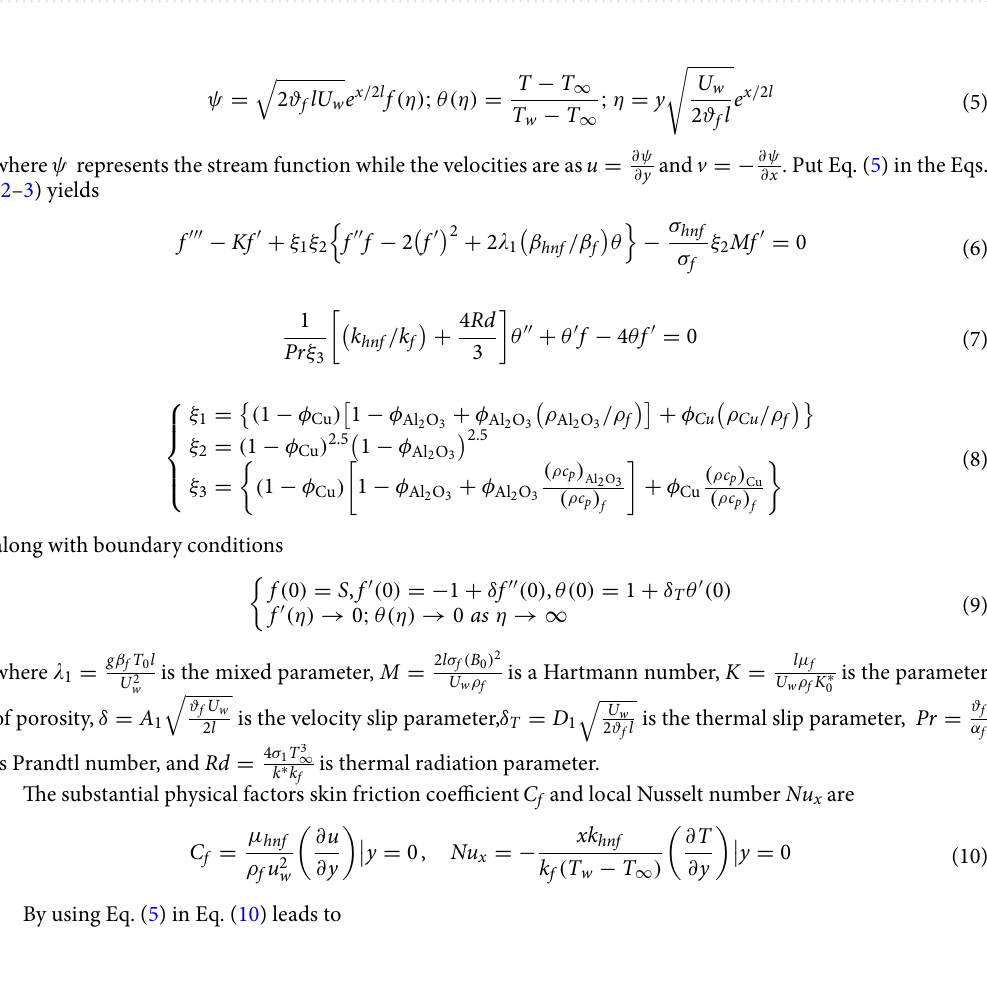
∂ψ ∂ψ v ∂ x . Put Eq. (5) in the Eqs. ∂ y and = − =